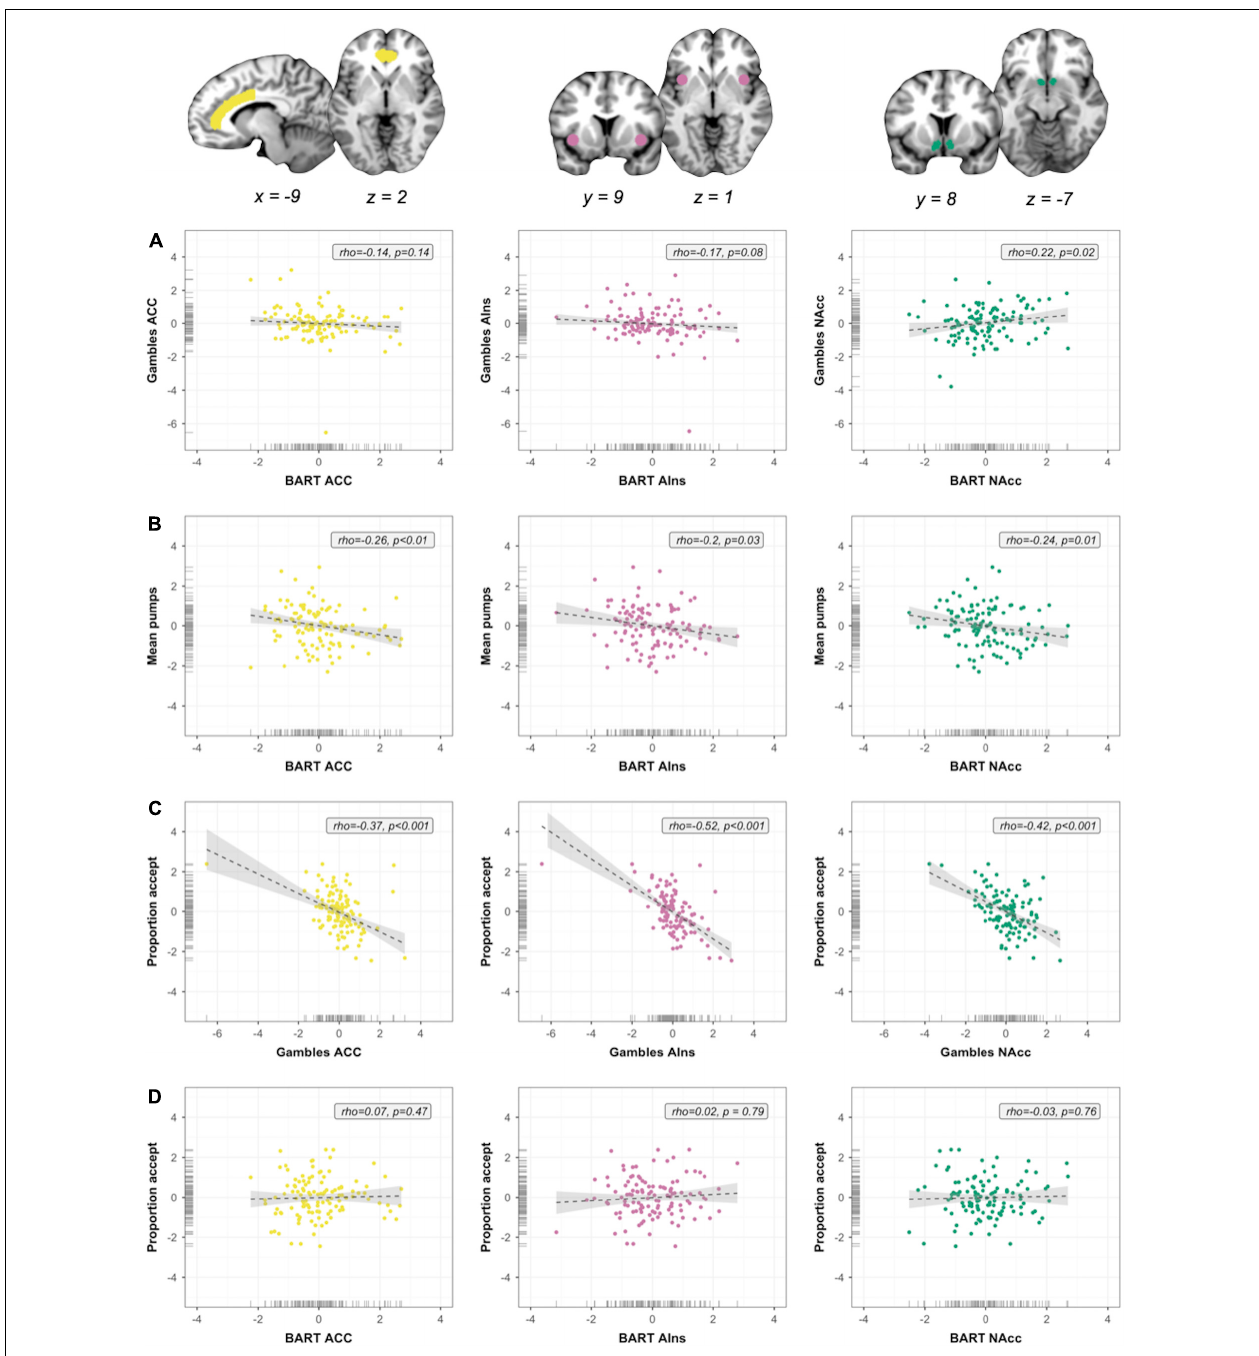
FIGURE 4 | Within-session individual differences. Scatterplots show associations between neural indices, as well as between neural and behavioral indices. Columns represent neural signal extracted from three ROIs [anterior cingulate cortex (ACC), anterior insula (AIns), and nucleus accumbens (NAcc), in that order]; rows represent analyses. (A) Associations between regional neural signals across measures (brain–brain). (B) Within-measure brain–outcome associations for Balloon Analog Risk Task (BART). (C) Within-measure brain–outcome associations for monetary gambles. (D) Out-of-measure brain–outcome associations. Note: All variables were regressed on age and gender and standardized prior to plotting and analysis. Regression slopes were estimated using robust regression